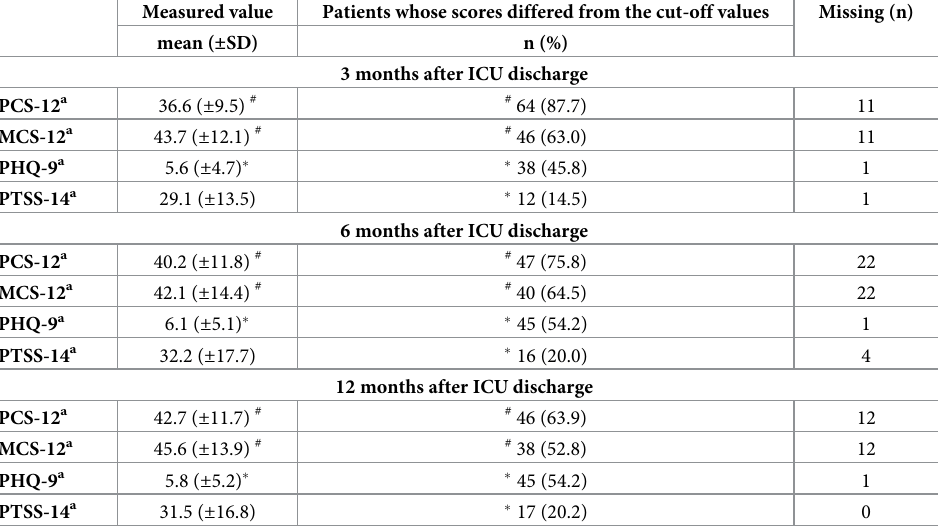
Table 3. HRQoL and symptoms of psychiatric disorders in ARDS survivors after 3, 6 and 12 months (N = 84). Measured value Patients whose scores differed from the cut-off values Missing (n) mean ( ±